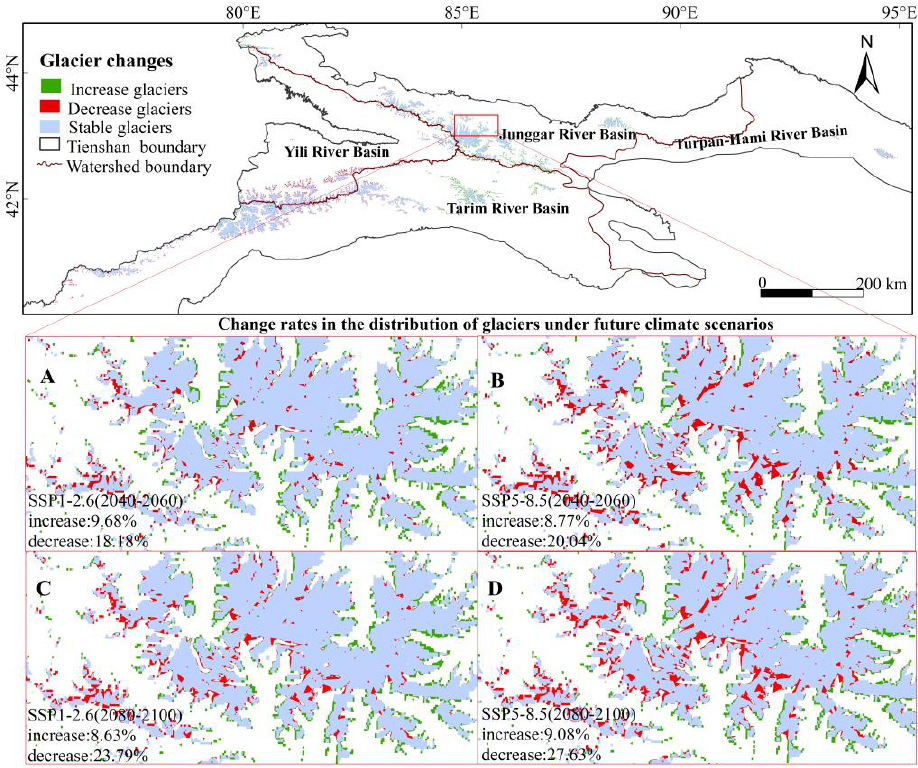
Figure 5. Changes in the distribution of glaciers under future climate scenarios. Compared with the reference year (1970–2000), the potential distribution of glaciers in SSP1-2.6 ( A , C ) and SSP5-8.5 ( B , D ) scenarios in the middle and late of the 21st century.